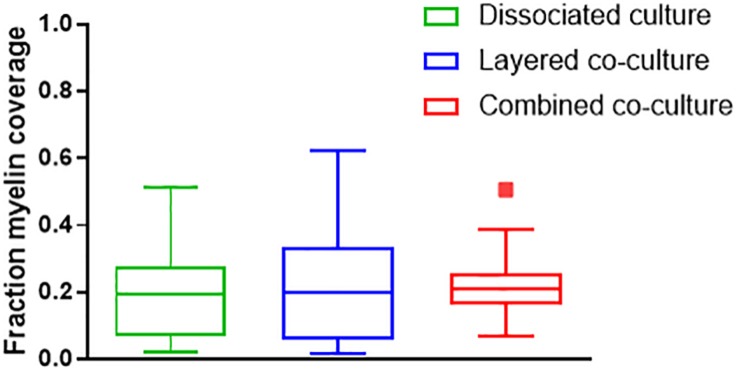
Assessment of average myelin coverage as fraction of total image area inferred from PLP/DM20 positive staining. Data acquired at 35 days in co-culture (n = 3).